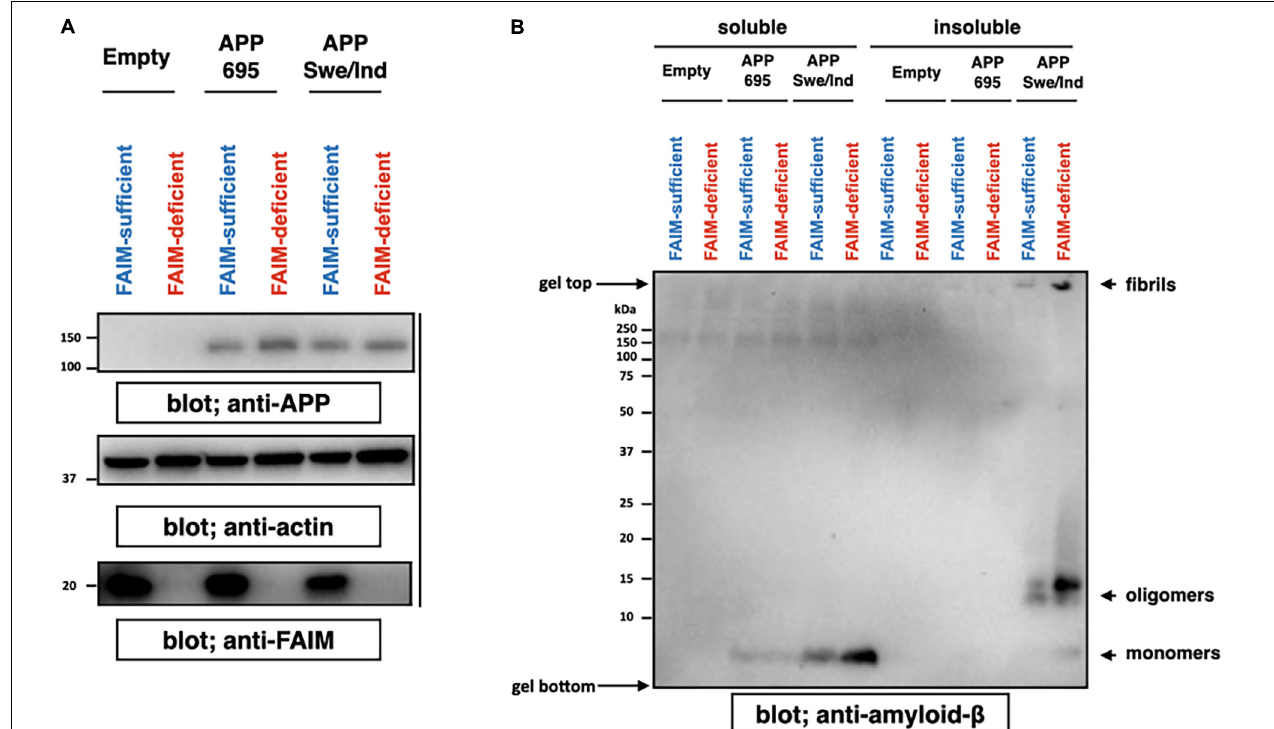
FIGURE 1 | FAIM KO cells accumulate insoluble A β fibrils/aggregates. WT and FAIM KO Neuro 2A cells were transiently transfected with expression vectors for APP695 and mutant APPswe/ind. Four days later after the transfection, cells and culture supernatants were harvested. (A) Cell lysates were prepared using RIPA buffer, and were analyzed by western blotting for APP, FAIM, and actin as a loading control. (B) Culture supernatants were fractionated into soluble and insoluble pellet fractions by centrifugation at 14,000 × g for 10 min. Pellets were washed twice with PBS. Proteins from the supernatants for each fraction were analyzed by western blotting for A β . Representative data from at least three independent experiments are